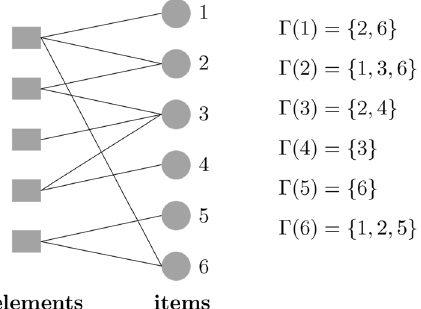
Fig. 1 The neighbor structure of a BMCP instance with 5 elements and 6 items. The edges represent the relationship between the ele- ments and the items. The neighbors of each item are presented on the